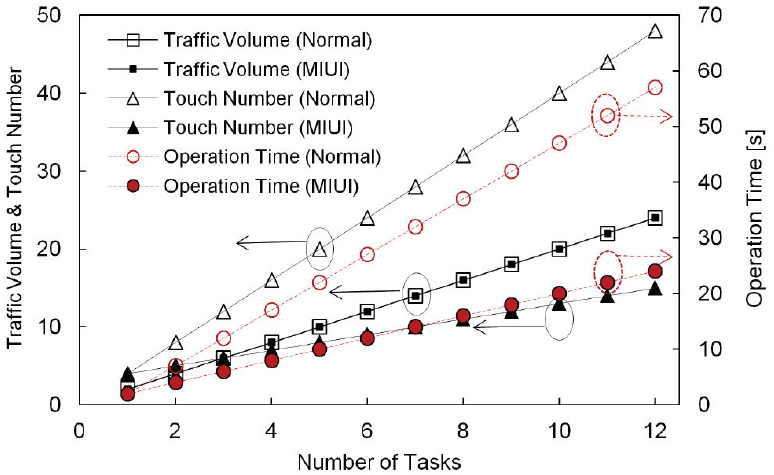
Figure 5. User convenience: Comparison of traffic volume, touch number, and operation time versus the number of tasks.